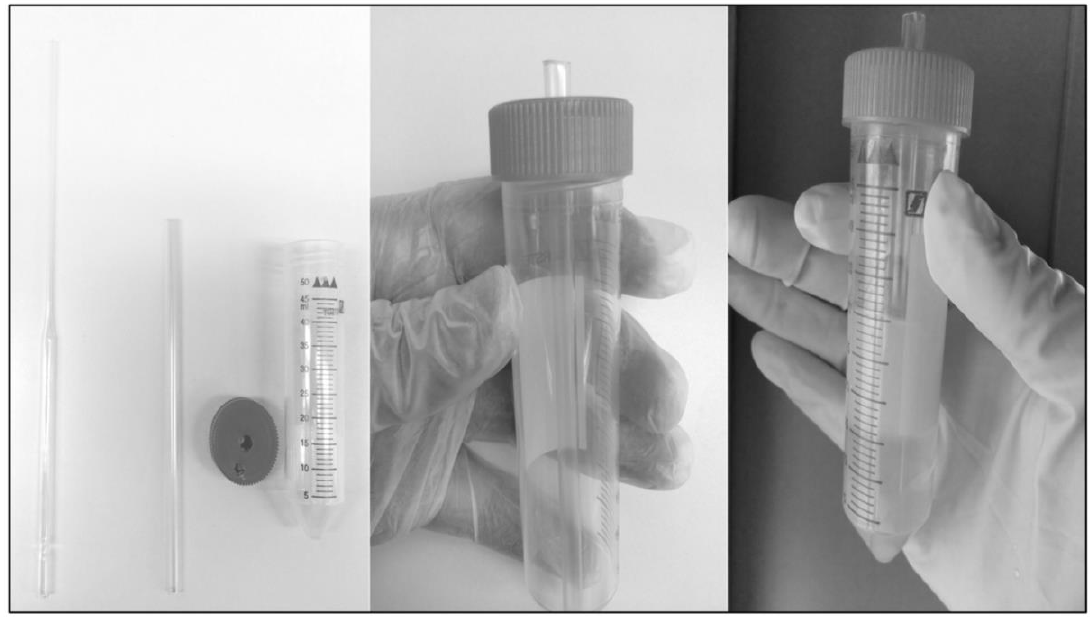
Figure 1. Modified Single Layer Centrifugation (MSLC). A 50 mL sterile tube with a sterile 5 mL plastic inner tube inserted through the middle of the cover, and a small hole that had previously been made at the edge of the lid. The colloid is poured into the 50 mL tube, the lid containing the insert is screwed on, and the semen samples are added through the small hole near the edge of the lid. After centrifugation, the sperm pellet can be retrieved easily by passing a long Pasteur pipette through the plastic insert.